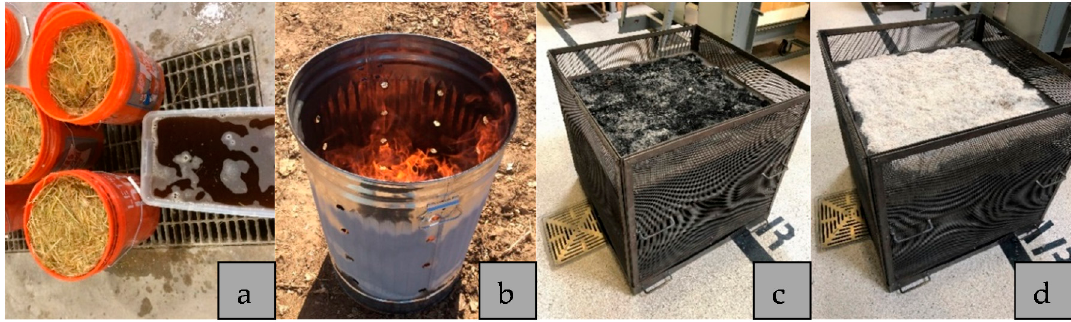
Figure 1. Rice husk ash (RHA) and rice straw ash (RSA) production process; ( a ) Water pretreatment; ( b ) initial burning; ( c ) ash after initial burning; ( d ) ash after final burning in the kiln .